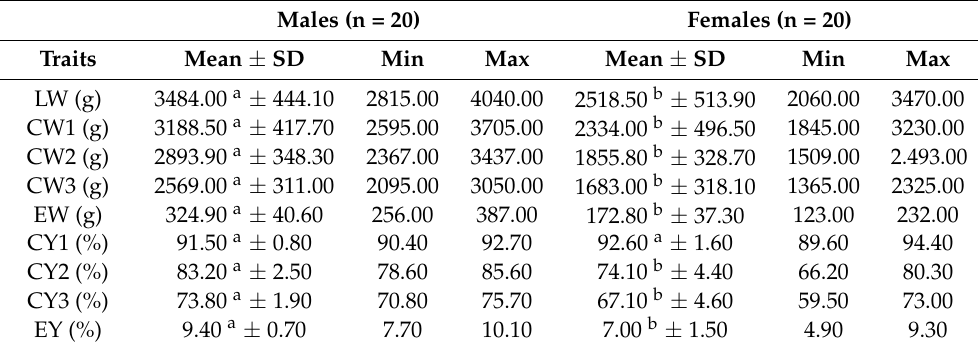
Table 1. Weights and carcass yield of the males and females of the “Branca” breed (mean ± SD, Min and Max).